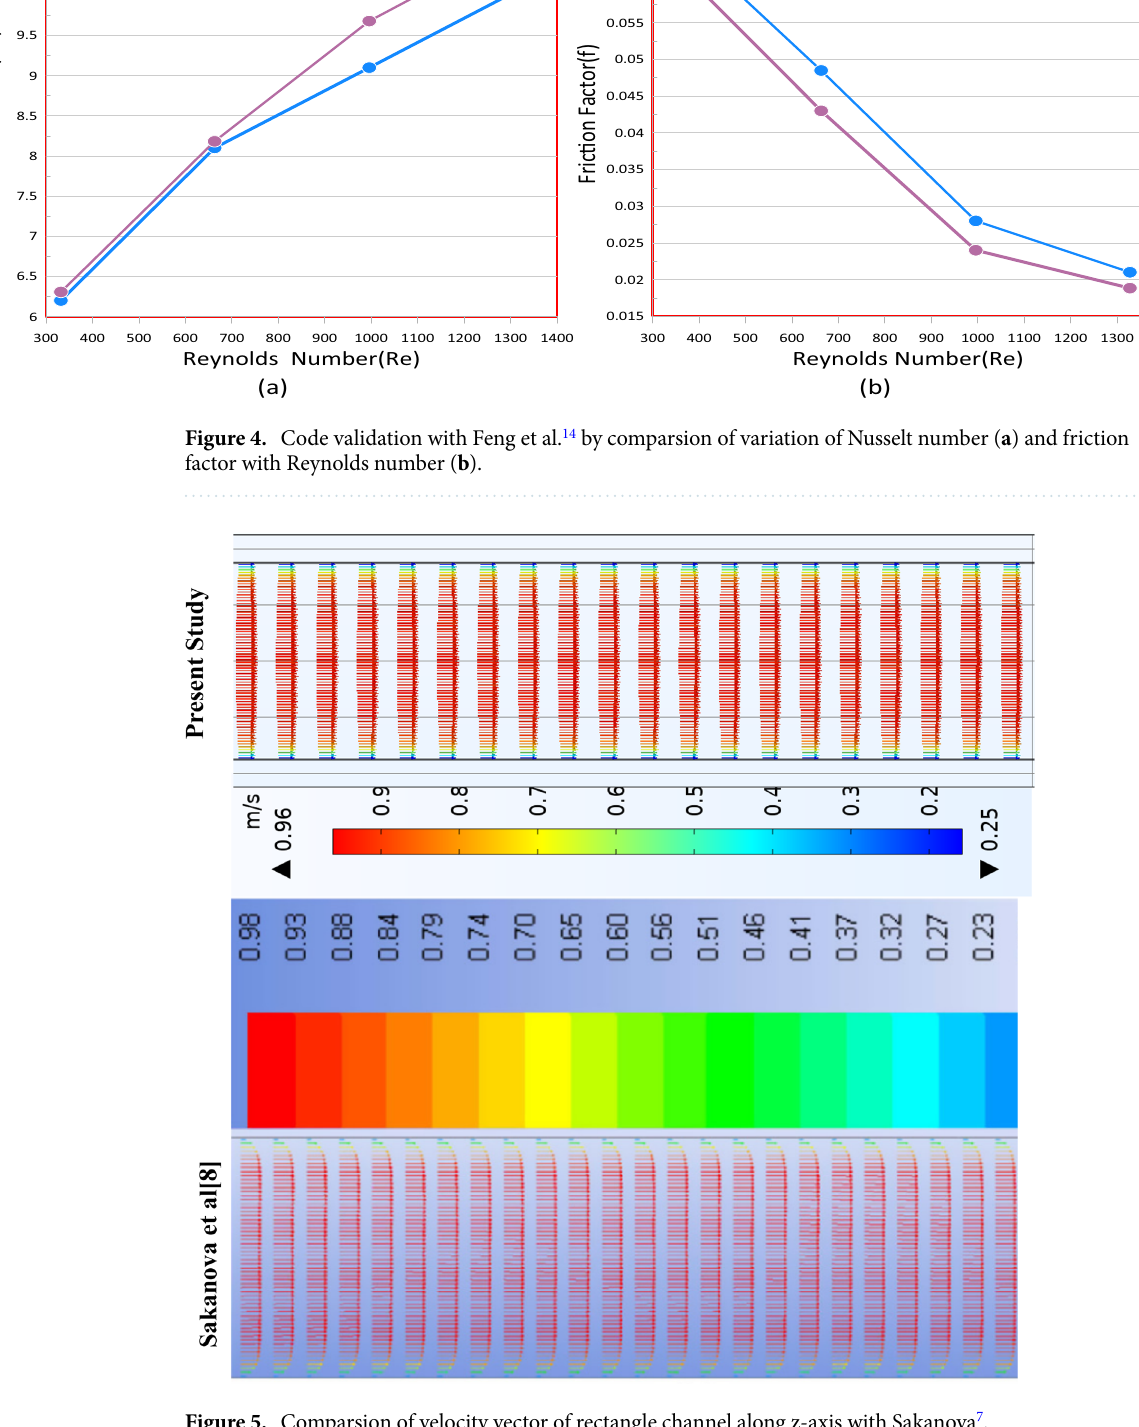
Figure 5. Comparsion of velocity vector of rectangle channel along z-axis with Sakanova 7